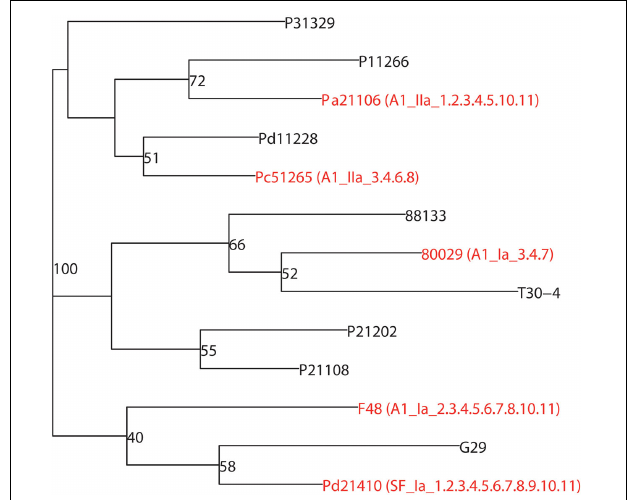
FIGURE 1 | Five diverse P . infestans strains with highly divergent genetic backgrounds were chosen for RNA-seq. Thirteen representative strains were used to build a phylogenetic tree according to the Bruvo distance using the R package “poppor” (Bruvo et al., 2004). The strains 80029, F48, Pa21106, Pc51265, and Pd21410 marked as red branches in the figure, were selected to conduct RNA-seq. Mating type: A1 and SF (self-fertilization); haplotype: Ia and IIa; pathotype: virulence race indicated by Black’s potato